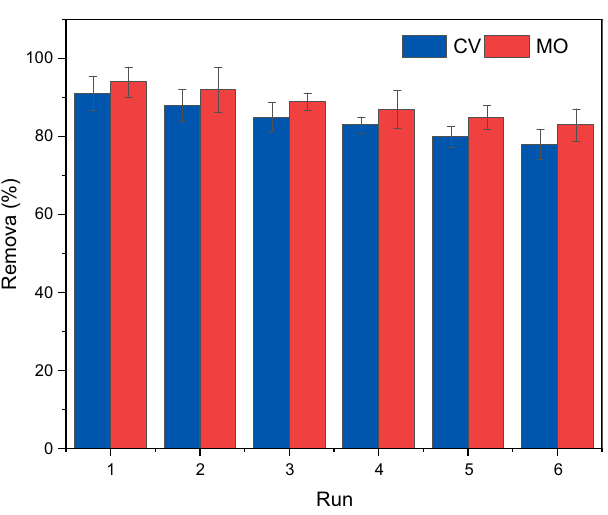
Figure 7. Adsorbent reusability for MO and CV adsorption by Fe 3 O 4 @inulin in terms of removal efficiency; T = 298 K, pH = 7 for CV and 5 for MO, C a = 0.5 g/L, C dye = 25 mg/L, t = 180